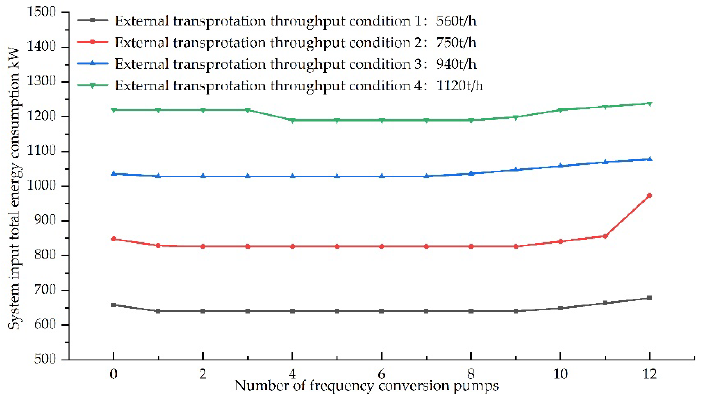
Figure 7. The adaptability study results of the number of variable frequency LNG submerged pumps under different external delivery conditions.